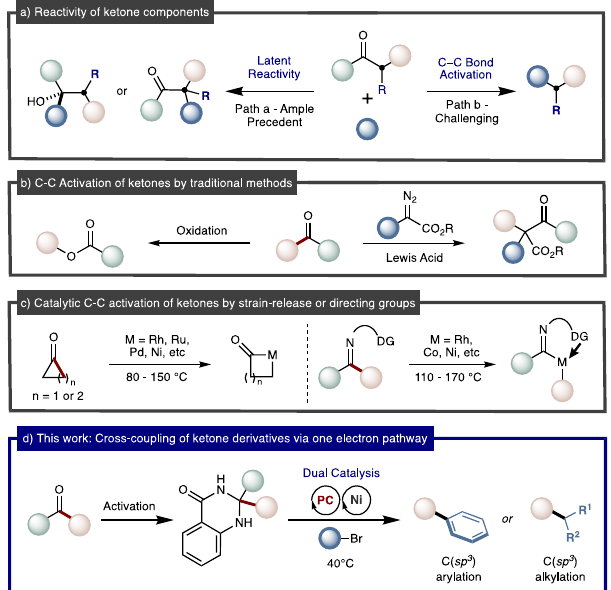
Fig. 1 C – C bond activation of ketone derivatives. a Reactivity of ketones. b Traditional methods for ketone C – C cleavage. c Strategies for catalytic C – C bond activation of ketones. d Metallaphotoredox approach for